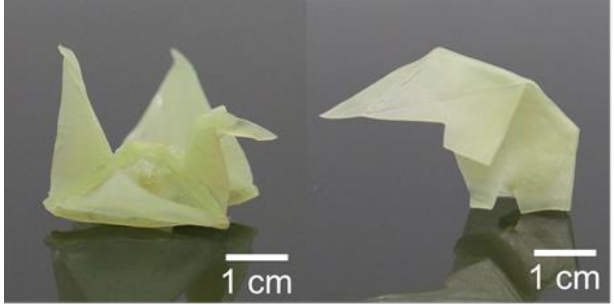
Figure 6. SMPs with permanent shapes of a bird and an elephant, respectively.